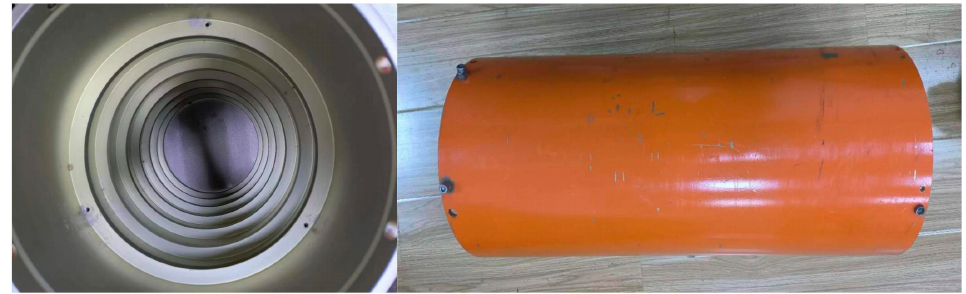
Figure 13. The physical picture of pressure hull.